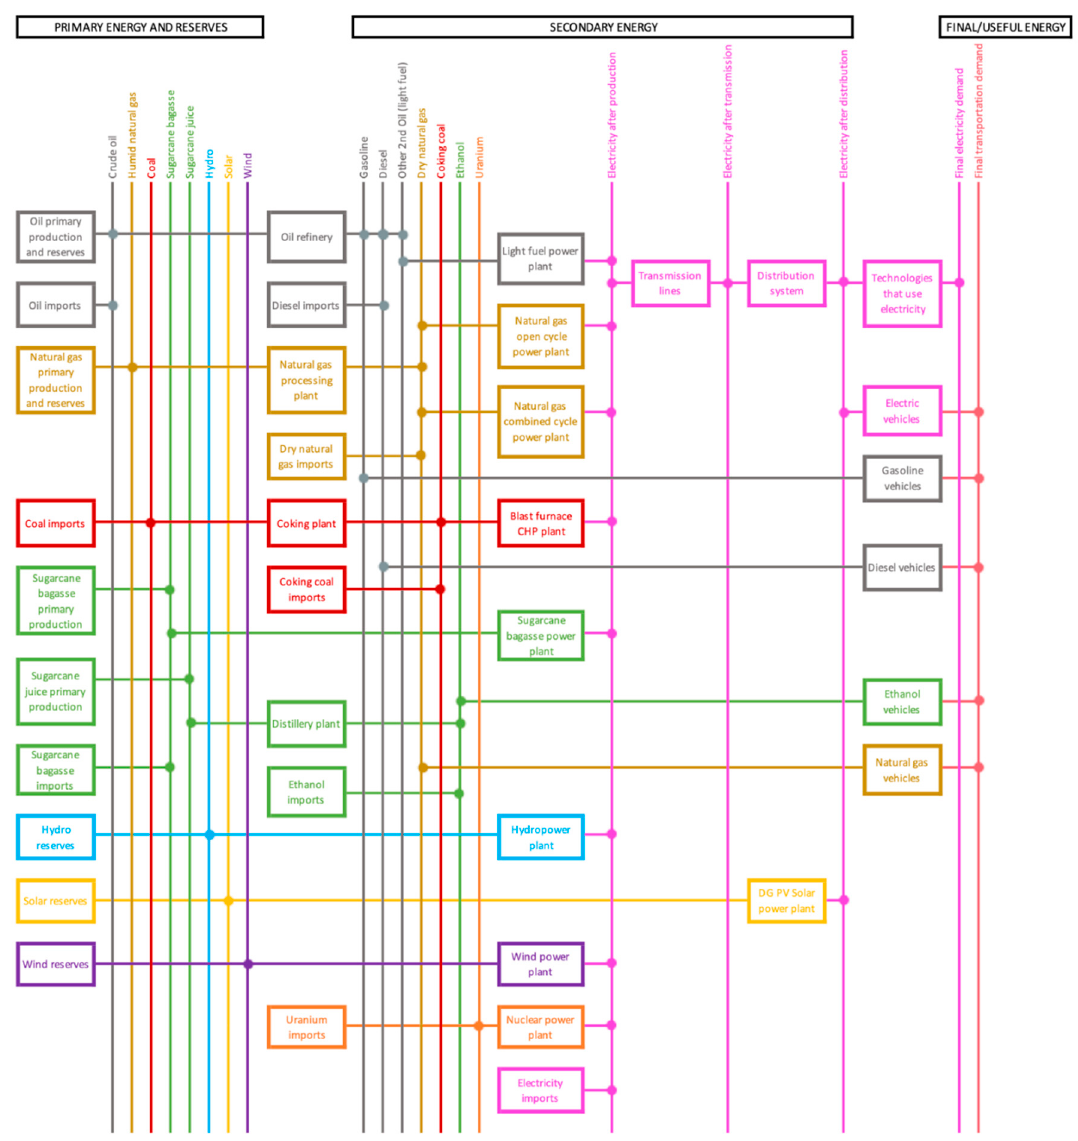
Figure 3. Rio de Janeiro state’s reference energy system (RES).